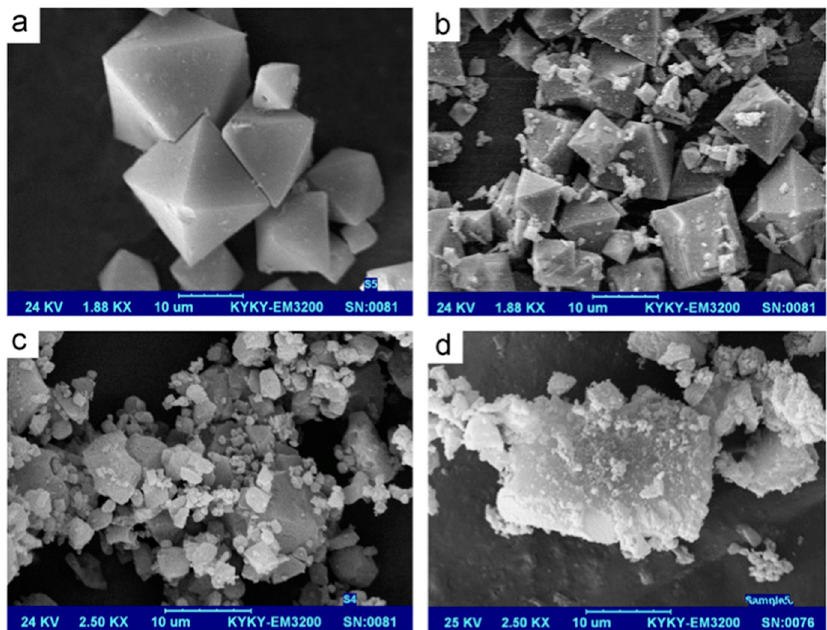
Figure 7. The SEM images of MOF ( a ) and magnetic MOF ( b – d ). Adapted with permission from [80]. Copyright (2012) Elsevier.